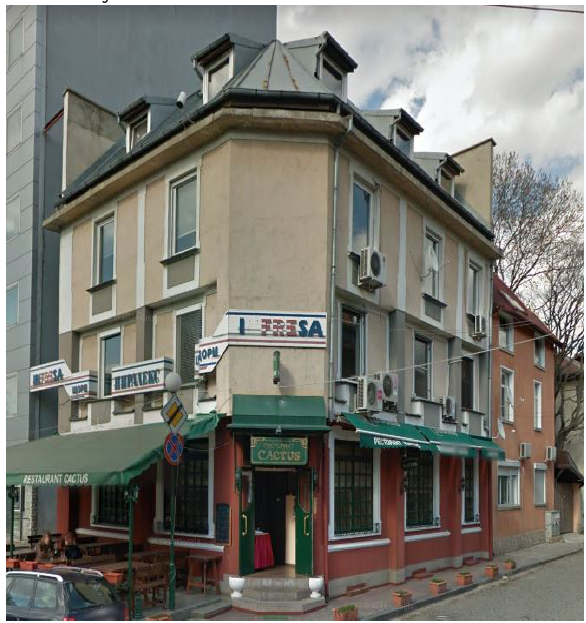
Figure 8: The buildings 3 and 4 in a parcel 68134.902.235